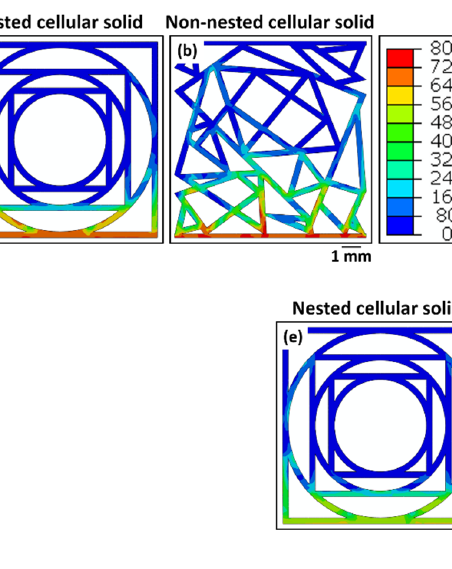
Figure 12. Simulated residual stress distribution on the cellular solid surfaces after cooling from the hotplate temperatures ( a , b ) 50 ◦ C; ( c , d ) 125 ◦ C; and ( e , f ) 200 ◦ C. The legend in Figure 12 shows the residual stress in